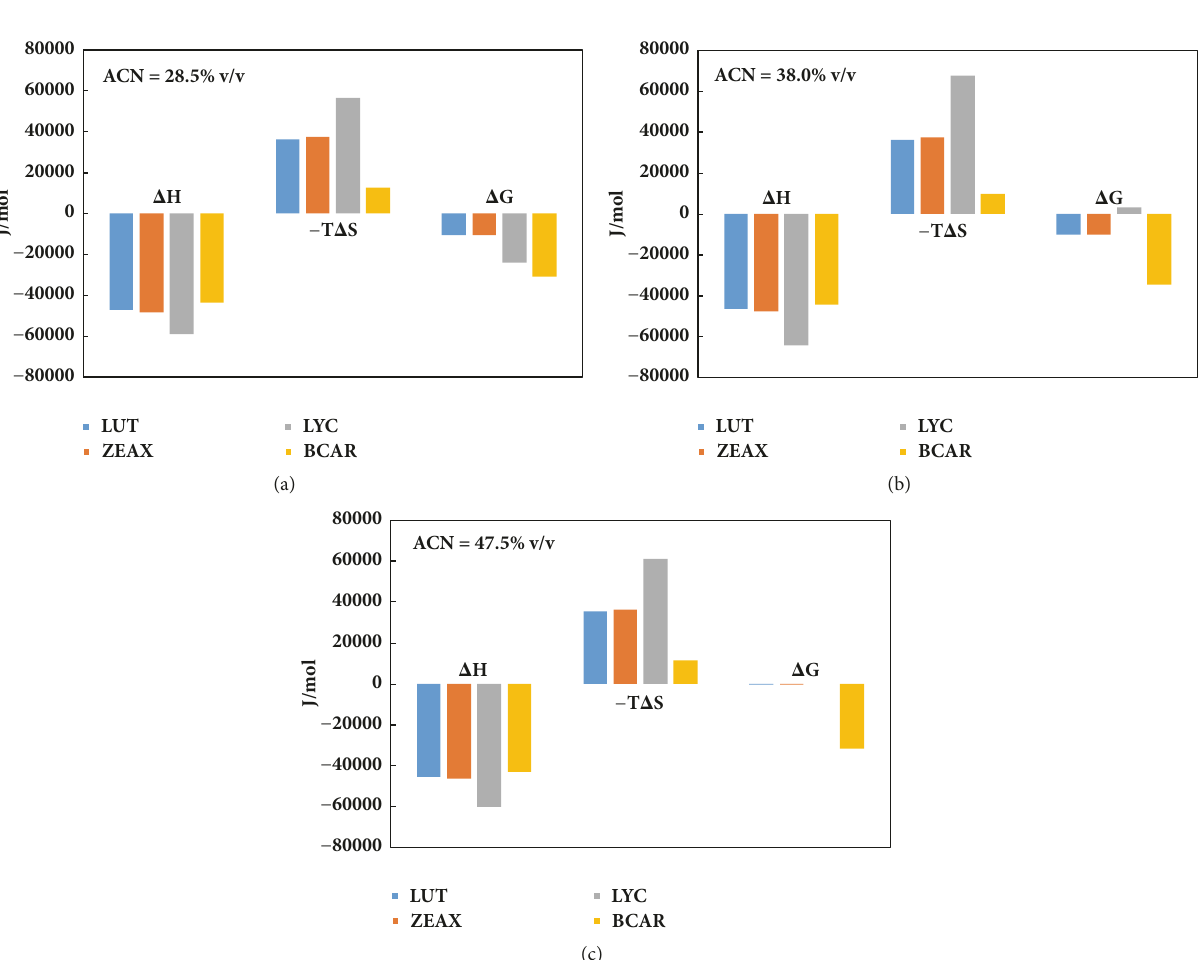
Figure 3: Thermodynamic quantities estimated by Van’t Hoff analysis at 298 K at different MP composition: (a) ACN=28.5% v/v; (b) ACN=38% v/v; (c) ACN=47.5%